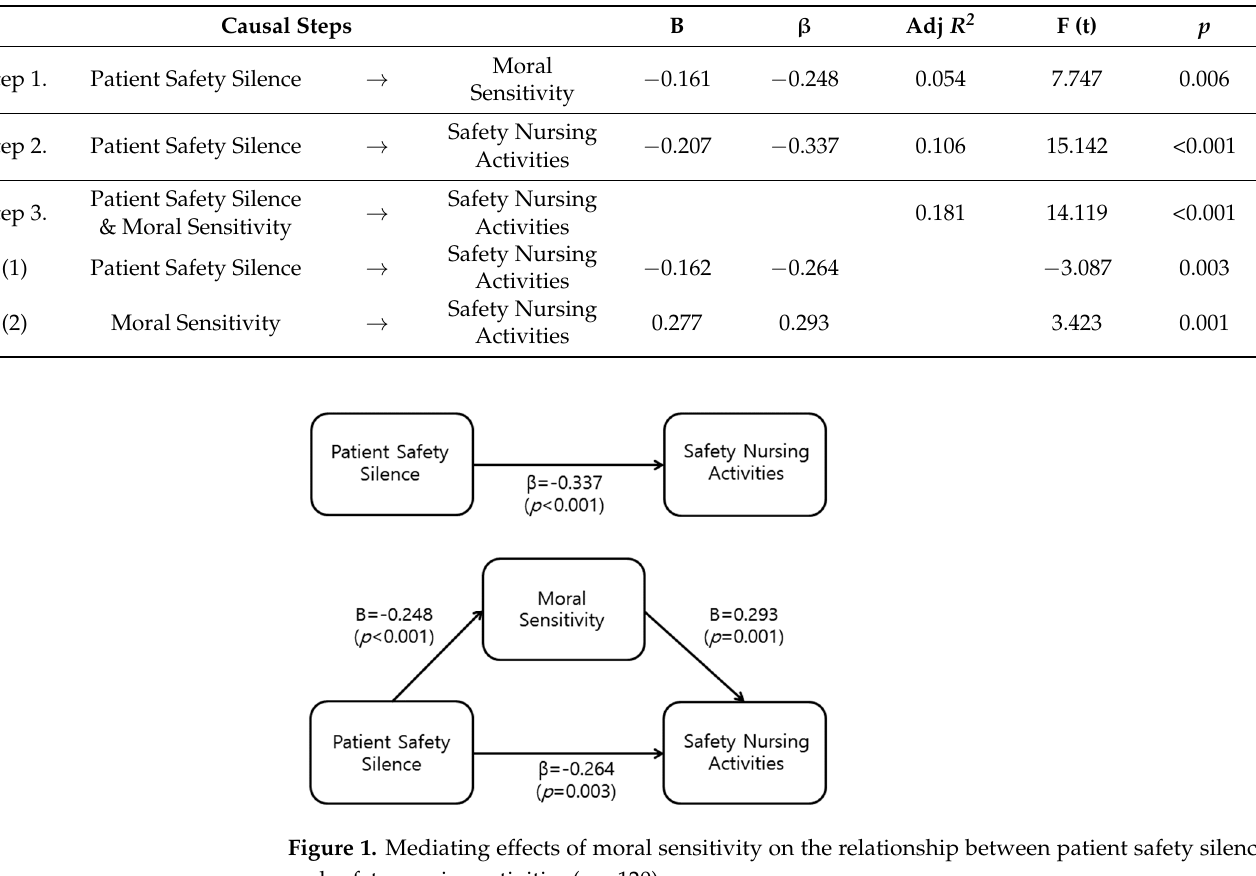
Figure 1. Mediating effects of moral sensitivity on the relationship between patient safety silence and safety nursing activities (n =